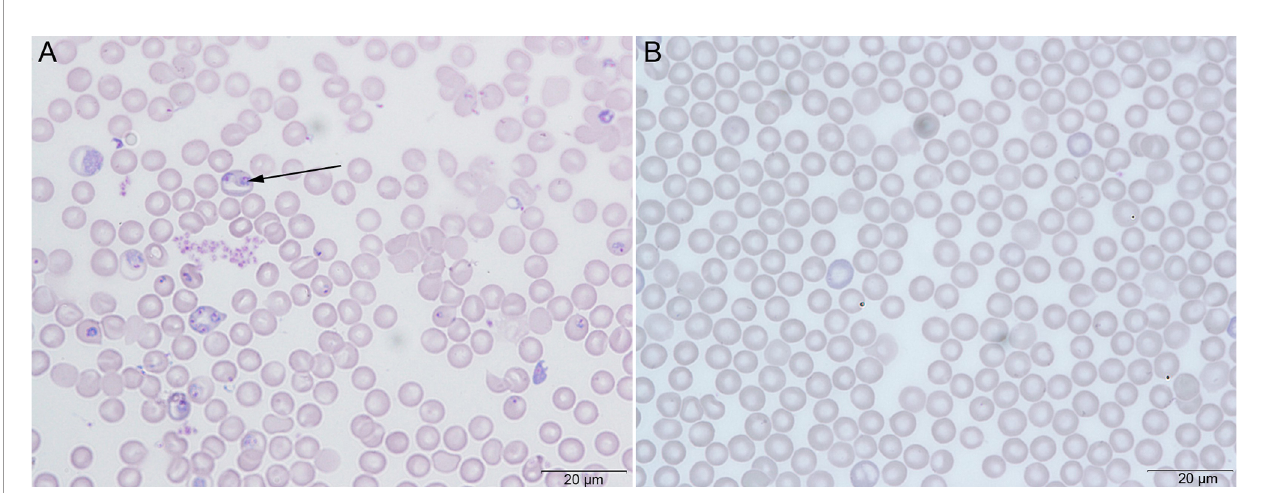
FIGURE 1 | Giemsa ’ s stain to check the parasitemia of Plasmodium berghei ANKA (PbA) in C57BL/6 mice. (A) The PbA group with successful parasite infection. (B) The control group (Ctrl) without parasite